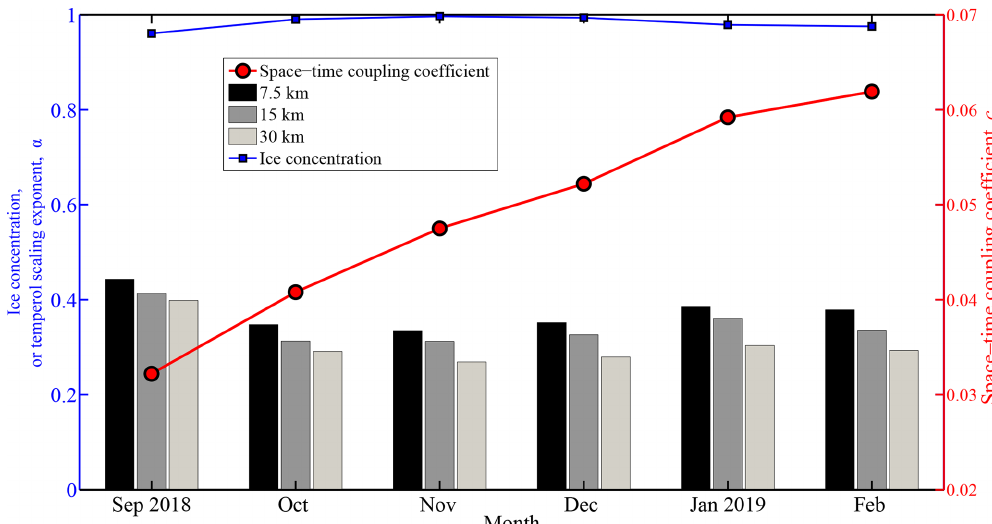
Figure 14. Changes in monthly temporal scaling exponent at various length scales, space–time coupling coefficient, and average ice concen- tration within the CHINARE buoy cluster.